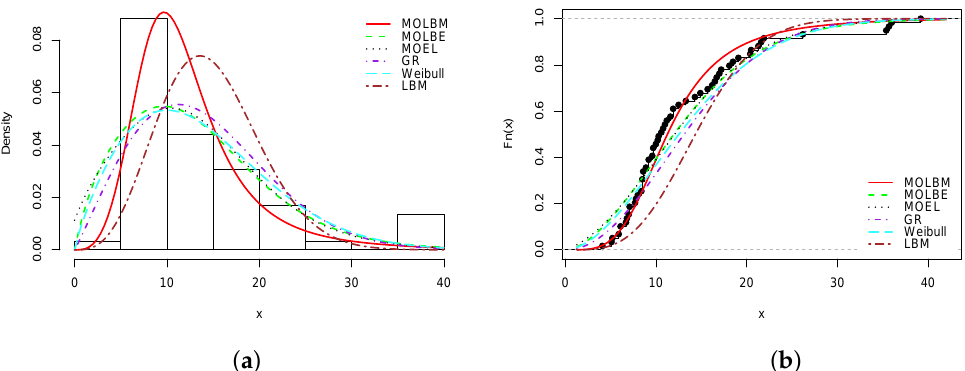
Figure 5. Plots of ( a ) estimated pdf and ( b ) estimated cdf of the MOLBM model with those of the other competitive models for Data set 3.